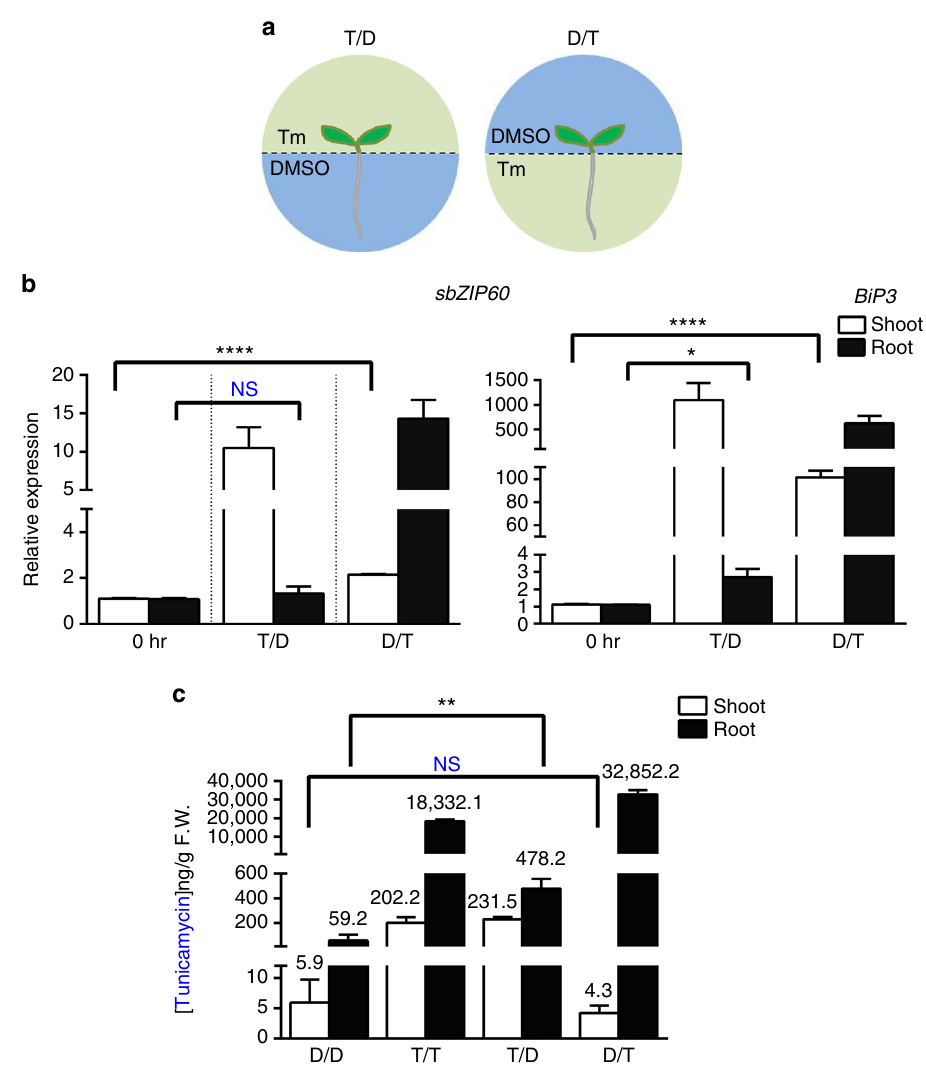
Fig. 3 Local ER stress ignites the UPR systemically, mostly in a shoot-ward direction. a Diagrams illustrating the Arabidopsis shoot – root split culture system in which the shoot and root of an intact seedling are exposed to separate growth media with different chemical conditions: mock DMSO (D) or 0.5 µ M Tm (T, Tunicamycin). T/D denotes shoot on Tm-containing medium and root on DMSO-containing medium; conversely, D/T denotes shoot on DMSO- containing medium and root on Tm-containing medium. b Quantitative RT-PCR analyses of UPR markers in 14-day-old wild-type seedlings treated with DMSO or 0.5 μ M Tm for 24 h as described in a . Values are presented relative to non-treated control (0 h), which was set to 1. Transcription of UBQ10 was used as internal control. Error bars represent s.e.m among three biological replicates. Data signi fi cantly different from the corresponding control are indicated by asterisks (* P < 0.05, **** P < 0.0001, NS, nonsigni fi cant; Unpaired t -test). c Quantitative HPLC/MS analyses of Tm content in shoot and root of seedlings after treatments as described in a in a shoot – root split culture system. The numbers over the histograms express ng g − 1 fresh weight (F.W.). Data signi fi cantly different from the corresponding control are indicated by asterisks (** P < 0.01, NS, nonsigni fi cant; Unpaired t